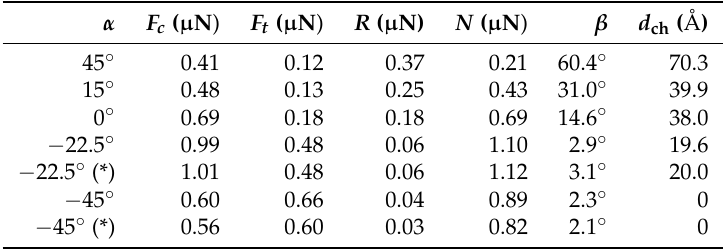
Table 1. Force and chip characteristics for various rake angles α : cutting force, F c ; thrust force, F t ; force components perpendicular, N , and parallel, F , to the rake surface of the tool; friction angle, β ; and chip thickness, d ch . Force values are averaged over the last 30 Å of cutting. For the negative rake angles, data were also obtained for a cutting length of 200 Å see Appendix B; in the rows marked by (*), averages over the last 100 Å of cutting are presented.